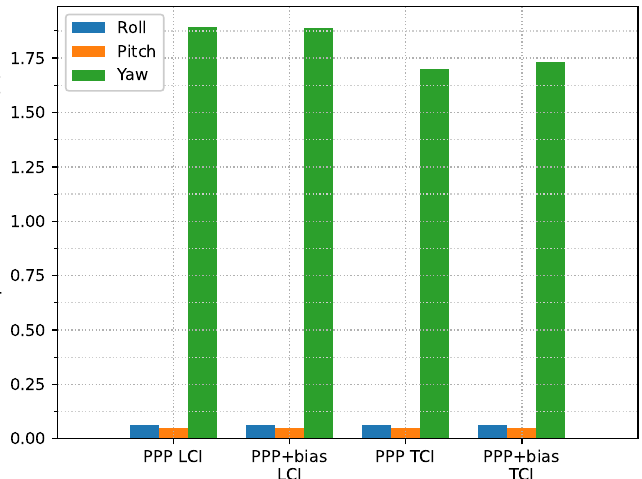
Figure 25. Attitude error RMS of real-time GPS/Galileo PPP/INS results of road bridge test on 11 February